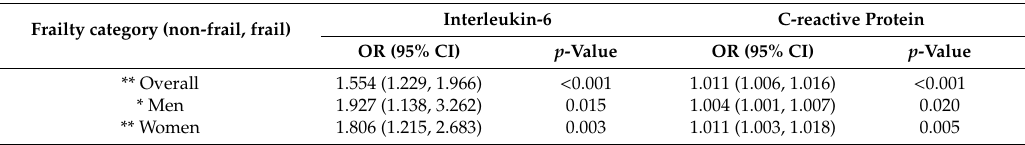
Table 6. Relationship of serum inflammatory biomarkers and the frail and the non-frail phenotype using binary linear regression analysis (odds ratios) with the comparison on gender e ff ects.